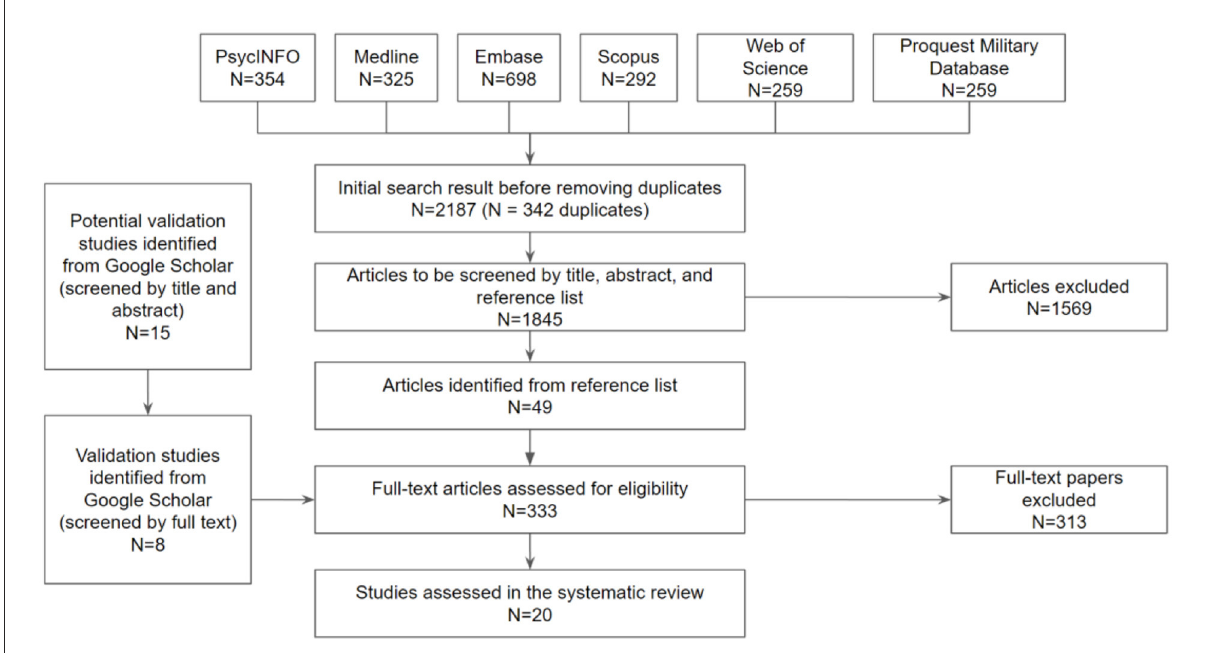
FIGURE1 Flow diagram of the study selection process from systematic